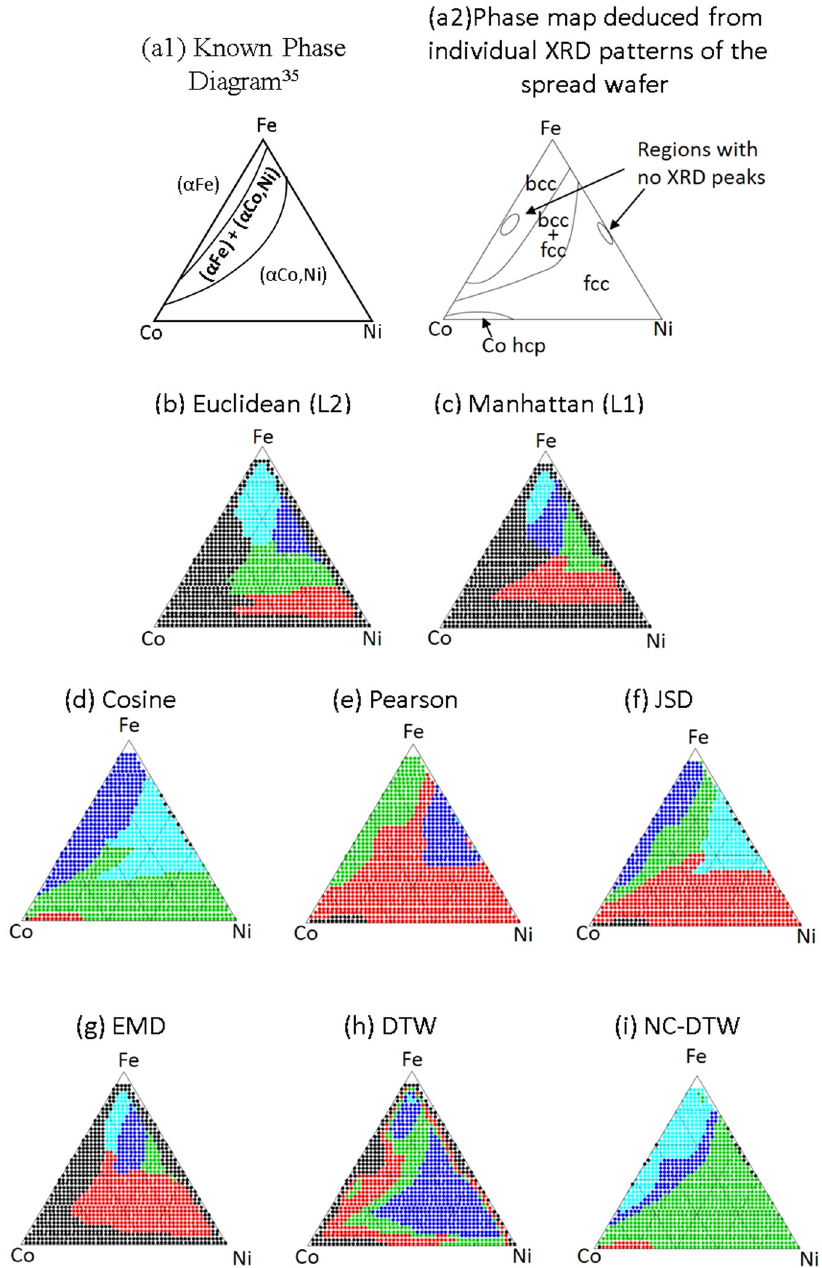
Fig. 2 Result of the hierarchical cluster (HC) analysis in the Fe – Co – Ni ternary alloy system with different dissimilarity measures. a1 Known phase diagram (ref. 35). a2 Phase map deduced from individual XRD patterns of spread wafer (ref. 29). b – i Result of the HC analysis with different measures: b Euclidean metric. c Manhattan metric. d Cosine metric. e Pearson metric. f JSD. g EMD. h DTW i